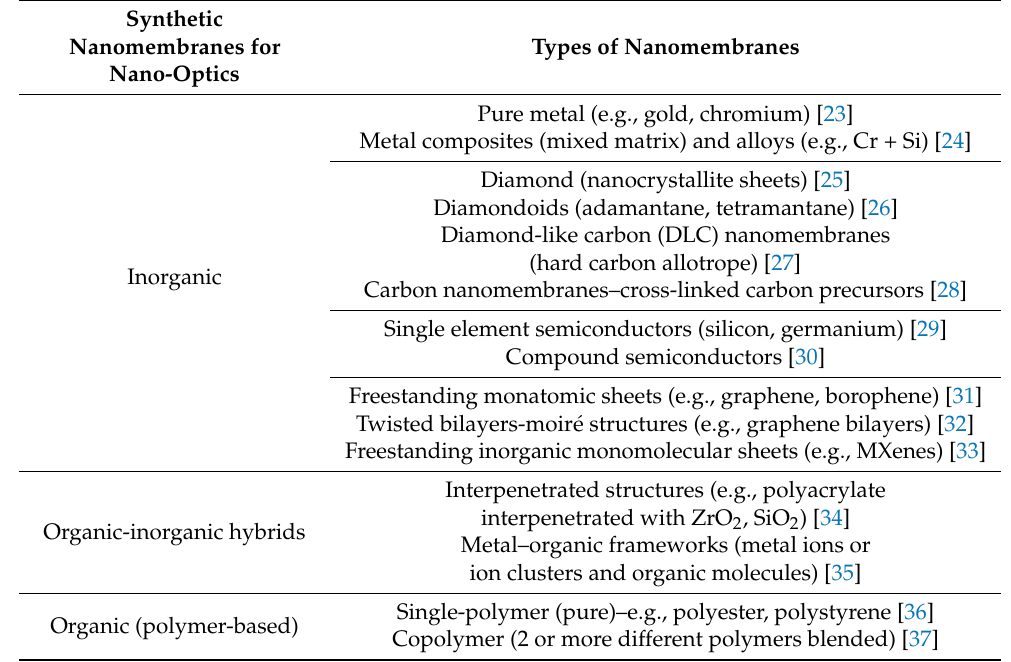
Table 1. Classification of synthetic nanomembranes for nano-optics based on their